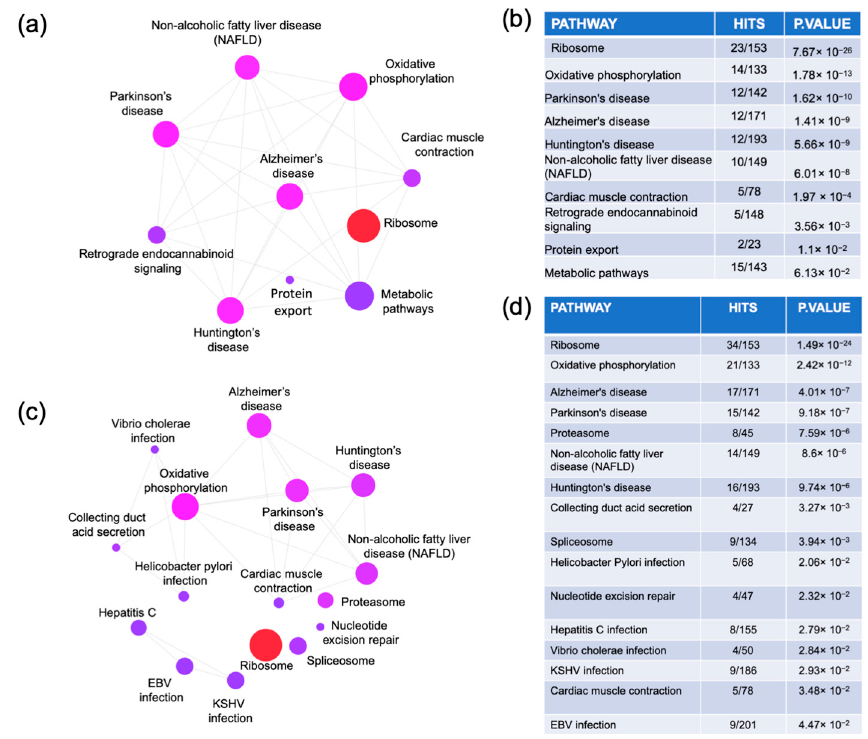
Figure 3. Pathway analysis. The genes that were commonly dysregulated in the MCI arrays ( a , b ) and in at least two of the ADD arrays ( c , d ) were obtained from the Venn diagram analysis. The genes lists were uploaded to https://www.networkanalyst.ca/NetworkAnalyst/faces/home.xhtml where an enrichment network analysis was performed using the Kyoto Encyclopedia of Genes and Genome (KEGG) database.